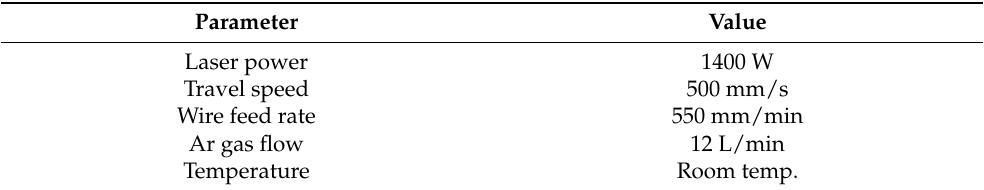
Table 1. LMD deposition parameters for W-steel µ-brush.